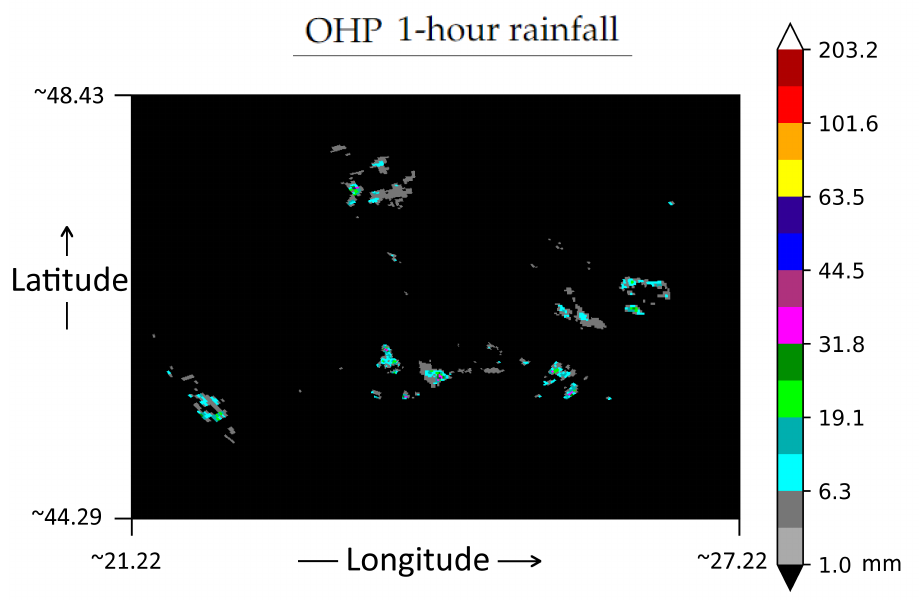
Figure 8. The 1-h rainfall estimation, in millimeters, using OHP for 27 June 2016 at